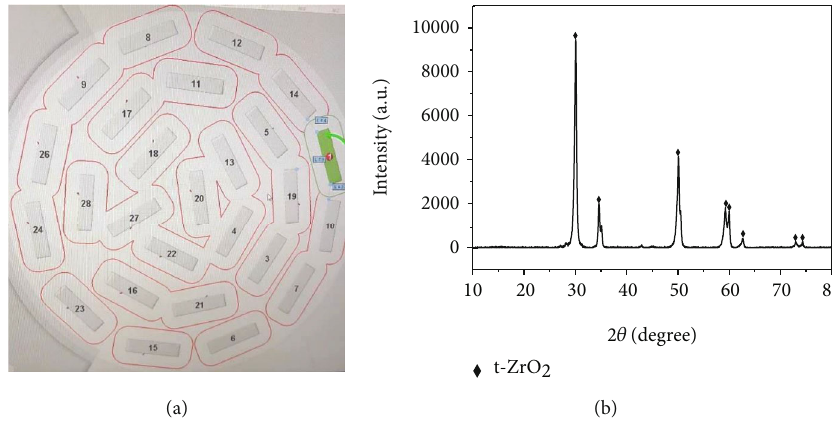
Figure 1: Preparation of specimens and X-ray di ff ractometer (XRD) detection. (a) CAD/CAM software was utilized for the typesetting and design of ST zirconium oxide fl ap disc. (b) The di ff raction pattern of X-ray di ff ractometer (XRD) detection. Table 1: Grinding head models and rotational speed parameters of polishing systems. Manufacturer